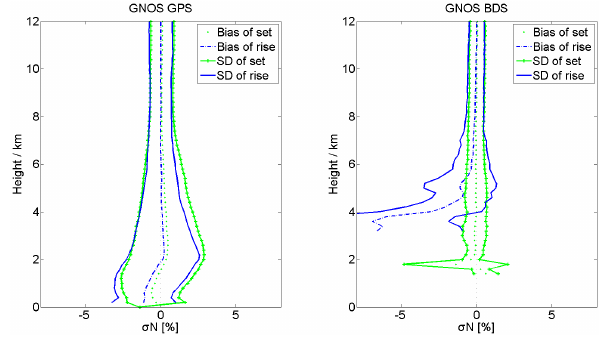
Figure 9. The bias and standard deviation of refractivity of GNOS GPS and BDS with respect to ECMWF reanalysis for the setting and rising occultations (from 1 November to 31 December